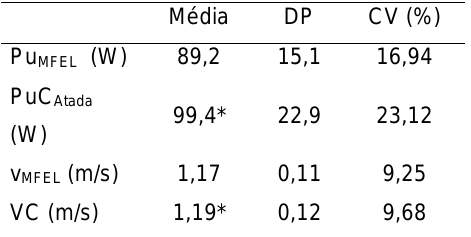
Tabela 1 são apresentados os valores de Tabela 1 : Valores de velocidade e de potência